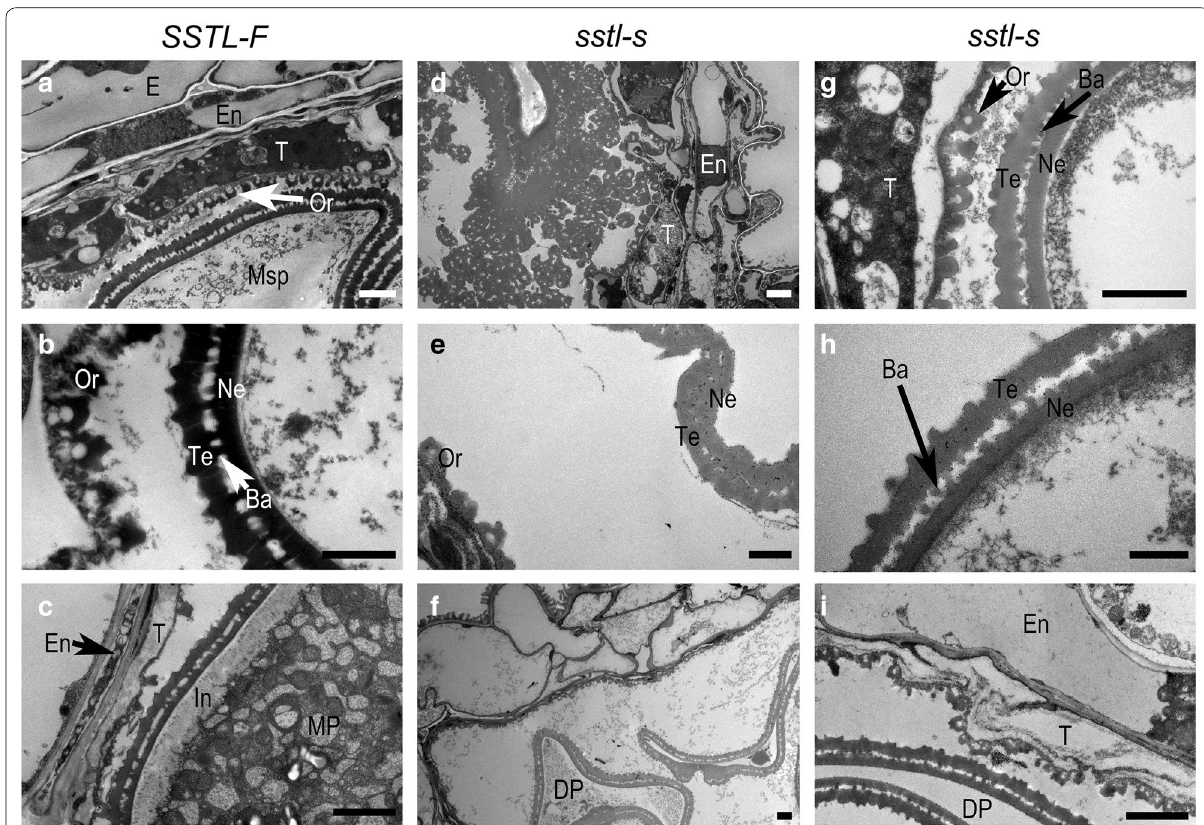
Fig. 4 TEM analysis of anther development in SSTL ‑ F and sstl ‑ s . a At vacuolated pollen stage (VP), when the tapetal cell was decomposed to generate orbicules in SSTL ‑ F and d , g sstl ‑ s . Bars 2 μm. b At late pollen mitosis stage (LpM), when the tapetum was degraded, and the pollen wall = of microspores integrated completely in SSTL ‑ F and e , h sstl ‑ s . Bars 1 μm. c At mature pollen stage (Mp), when endothecium degenerated and = microspores were in the plump round shape with puffy intine of SSTL ‑ F and f , i sstl ‑ s . Bars 2 μm. Ba Bacular, DP defective pollen, E epidermis, En =